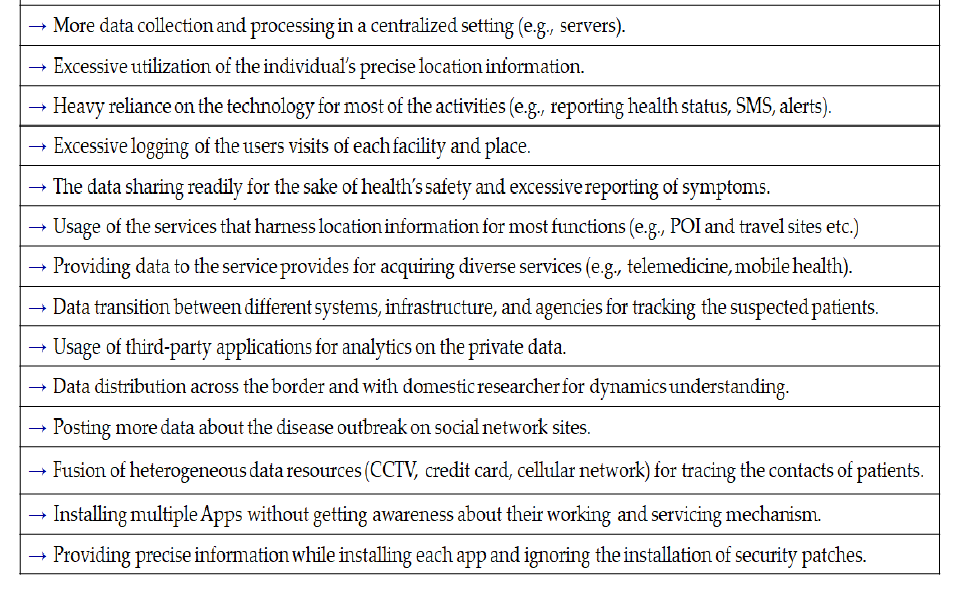
Figure 2. Technical features that made privacy a dilemma of research in recent